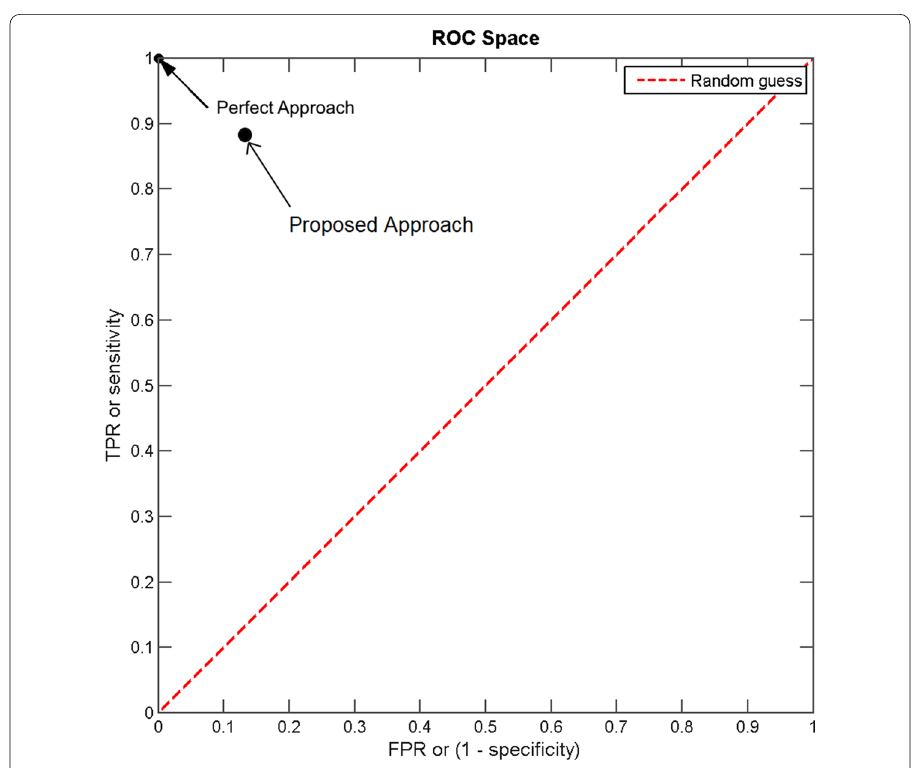
Fig. 14 The coordinate of our approach in ROC space